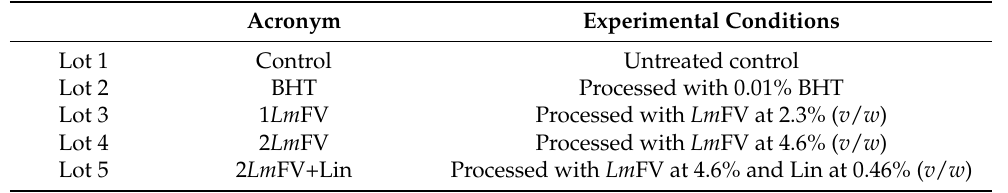
Table 1. Experimental conditions for sample